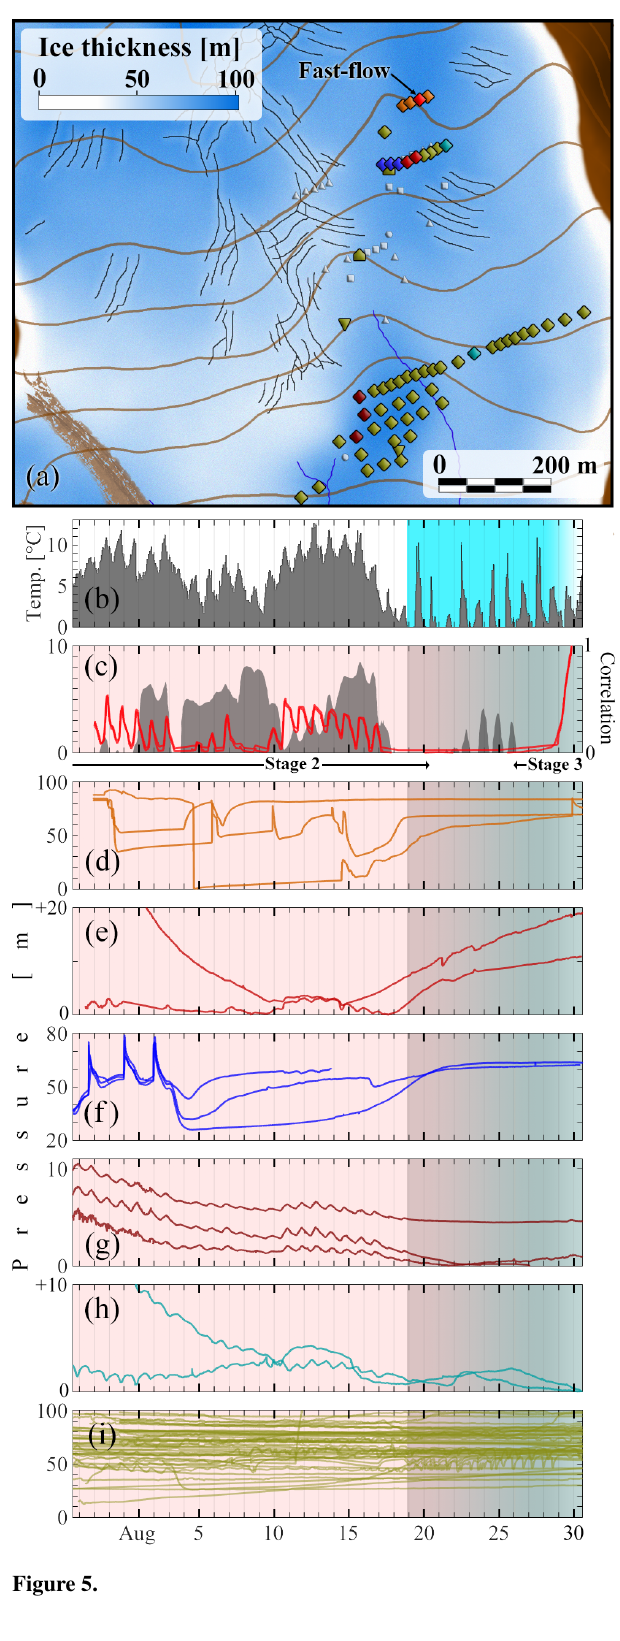
Figure 5. Locations and pressure time series for the boreholes as- sociated with the fast-flow borehole during the summer of 2013. (a) The map uses the same scheme as Fig. 2, but omits the up- stream area shading. (b) Temperatures (grey) and fresh snow cover determined from time lapse imagery (light blue shading, fading colour indicates partial cover). (c) Pressure in the fast-flow bore- hole (red) and its correlation with temperature in grey, computed for any given time over a 3-day running window. Note that two sensors were installed in the fast-flow borehole, offset vertically from each other by 70cm, making the two lines indistinguishable most of the time at the presented scale. Later in Sect. 3.5, the complete record will be displayed, where the two curves are more distinguishable. (d–i) Pressure records from other boreholes marked on the map. The colour of plots corresponds to borehole marker colours on the map; the same convention is used in all subsequent figures. Symbol shapes represent drilling years as in Fig. 2, uncoloured (grey) mark- ers correspond to boreholes with active sensors during the displayed period, the pressure time series of which are not shown in the